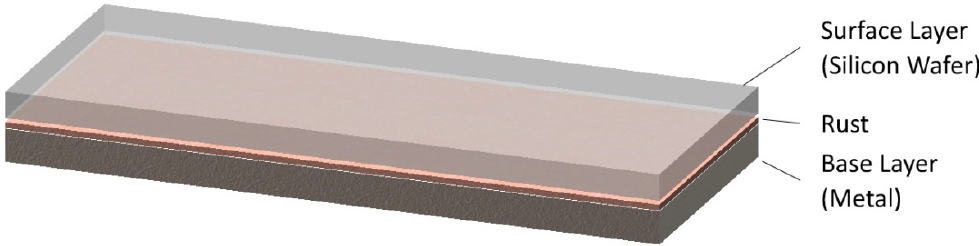
Figure 6. The structure of the “idealized” multilayer sample used in the experiment.